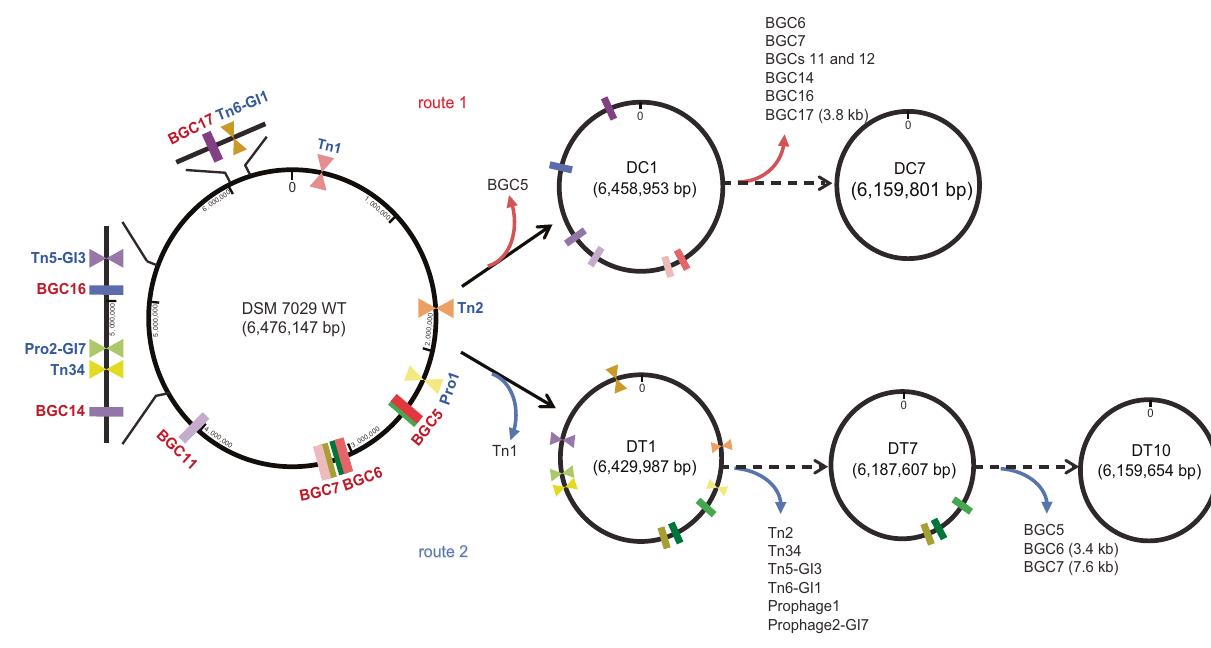
Fig. 1 The construction procedure of the genome-reduced mutants of DSM 7029. Circular genome map of the DSM 7029 wild type (WT), targeted deletion regions of biosynthetic gene clusters (BGCs) were marked with bold stubs of different colors and targeted deletion regions of transposases, GIs, prophages were marked with two opposite triangles of different colors on the physical localizations of the chromosome. The route 1 represents the sequential deletions of eight endogenous BGCs, resulting in the seven genome-reduced DSM 7029 strains DC1 – DC7. The route 2 represents sequential removals of several transposases, GIs, prophages, and vicinal nonessential genes, leading to the ten genome-reduced DSM 7029 strains DT1 –